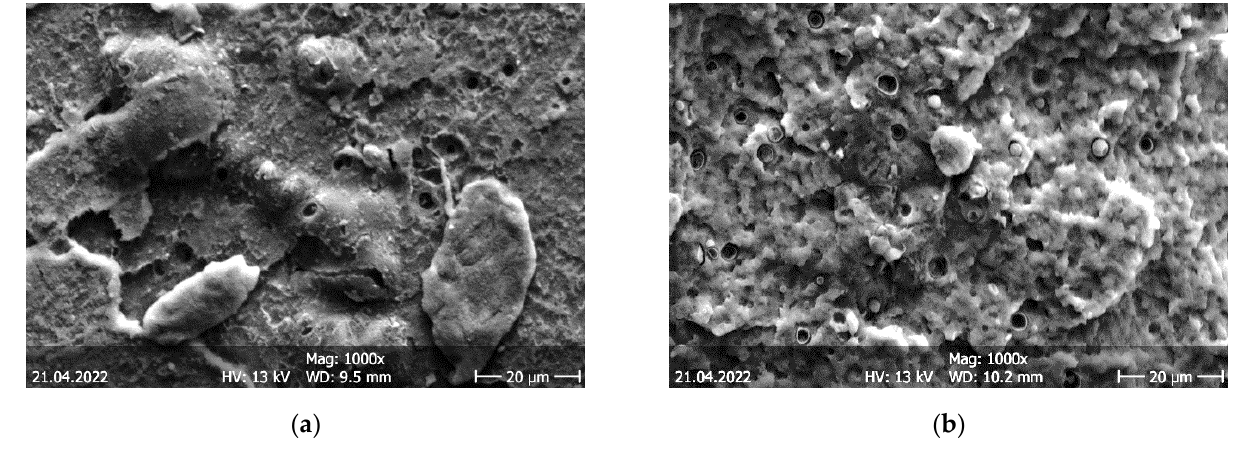
Figure 17. Scanning electron microscopy (SEM) images of rupture cross-sections of PLA Temp: ( a ) without thermal cycling; ( b ) after post-crystallization and 100 thermal cycles.